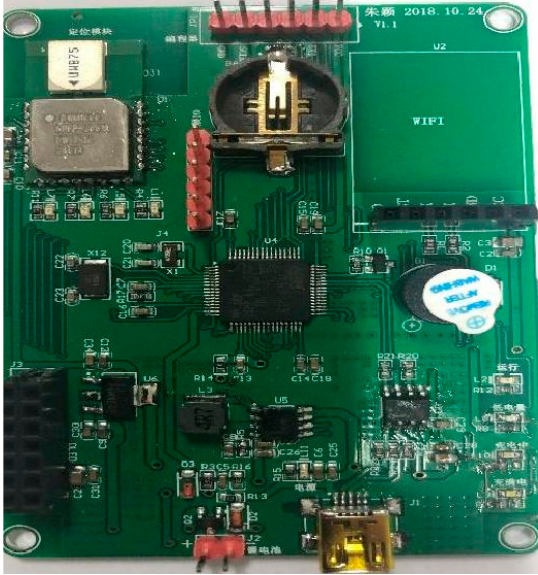
Figure 8. Positioning solution development board.